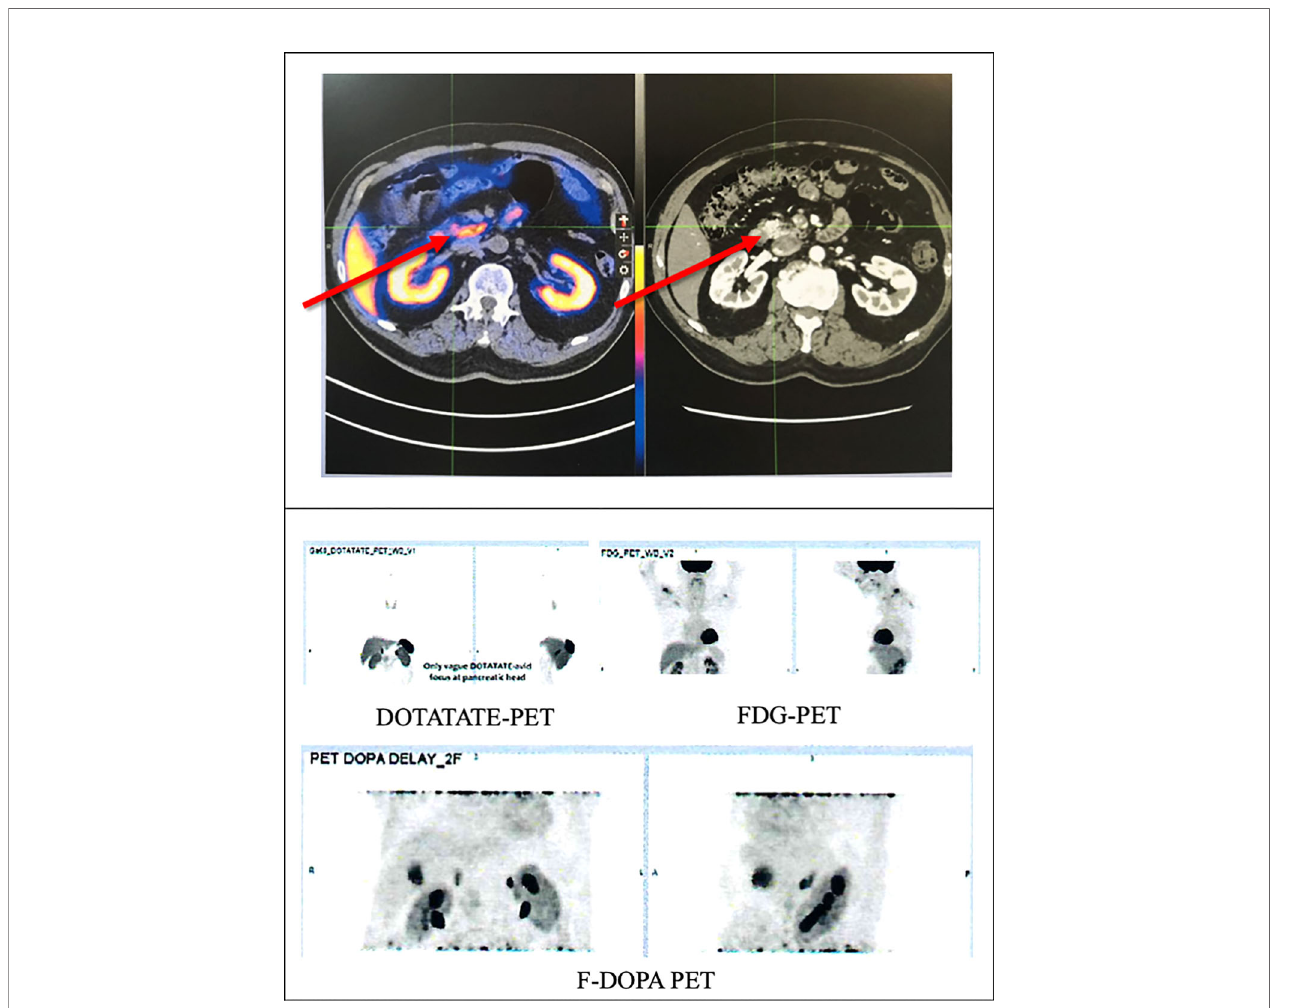
FIGURE 2 | PETCT scan of the patient showing a tumour in the pancreatic head with vague DOTATATE avidity (red arrows) but without FDG or F-DOPA avidity. FDG, 18 F- fl uorodeoxyglucose; F-DOPA, 18 F- fl uorolevodopa (F-DOPA); PETCT, positron emission tomography-computed tomography.